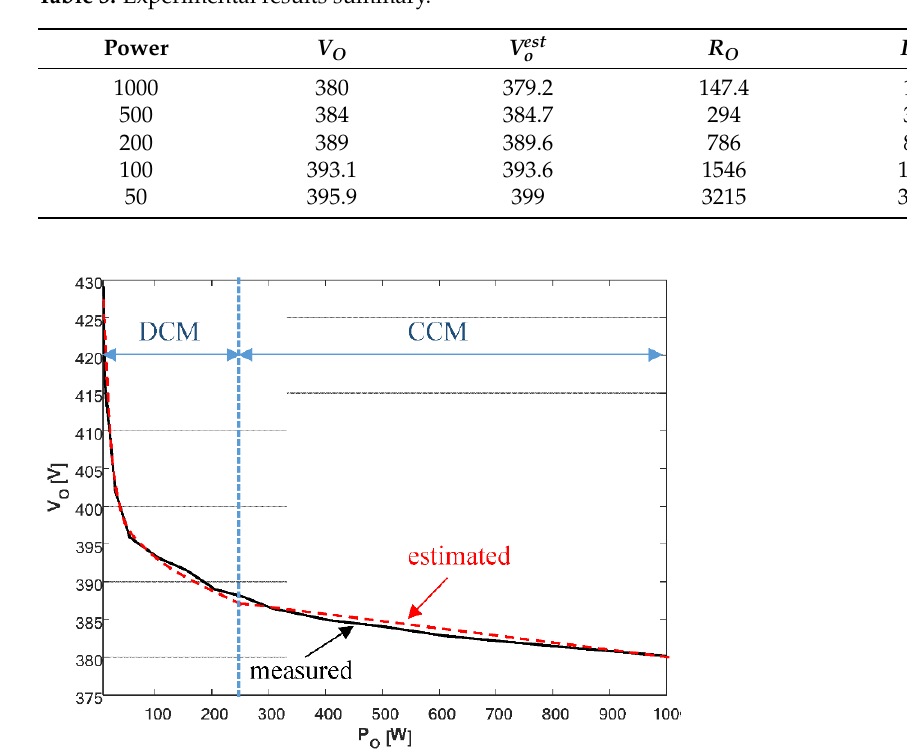
Table 3. Experimental results summary.